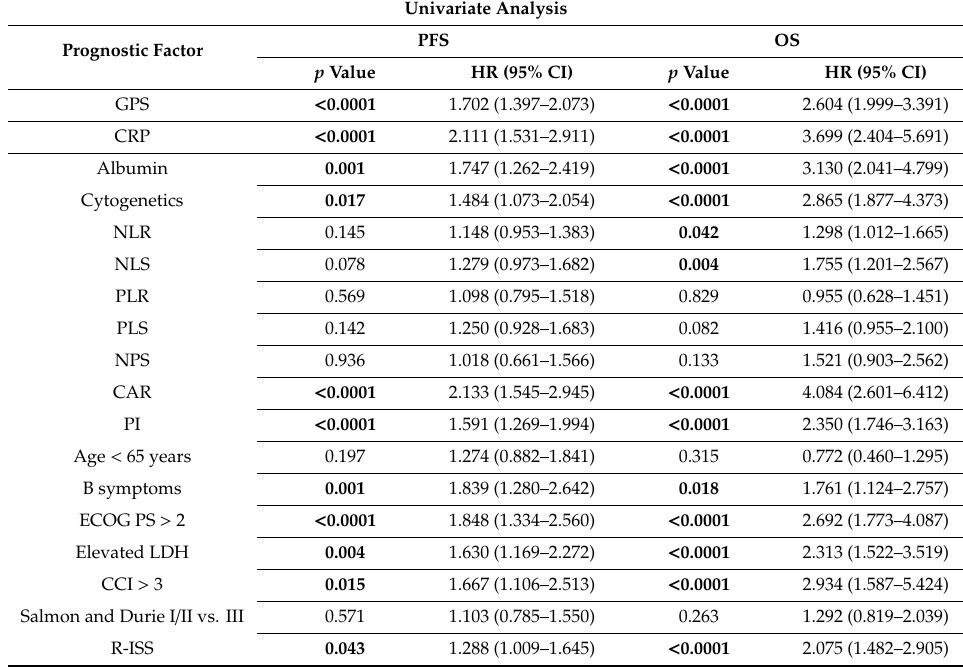
Table 6. Progression-free and overall survival in univariate analysis (univariate Cox